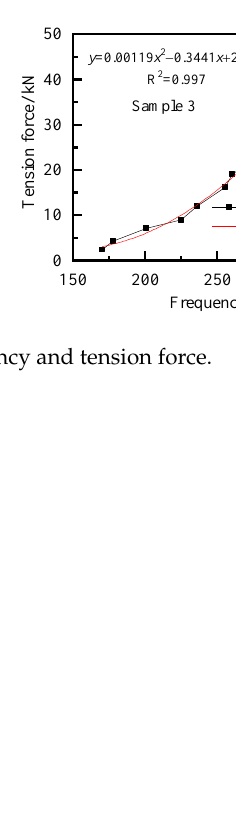
Figure 6. Error analysis between the experimental and calculated values of tension force.